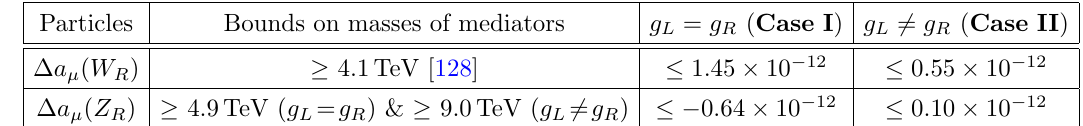
Table 6 . Estimated values of the individual contributions coming from W R and Z R in extended LRSM for the cases g L = g R and g L doublets can be found in ref. [87], from which we have obtained the lower bound on M Z framework.